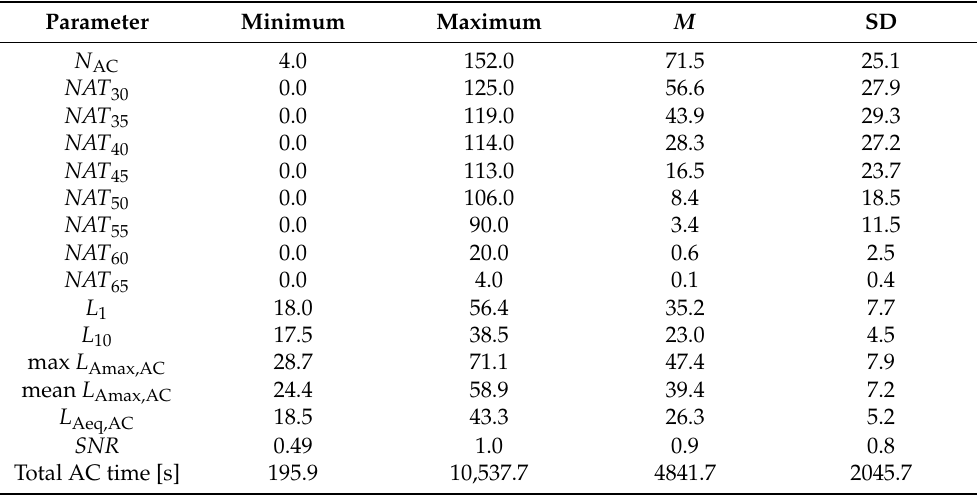
Table 1. Aircraft noise parameters averaged across study nights and subjects ( N = 48) based on the indoor measurements related to the individual bed times. Mean values ( M ) and standard deviation (SD) were calculated across study nights and across